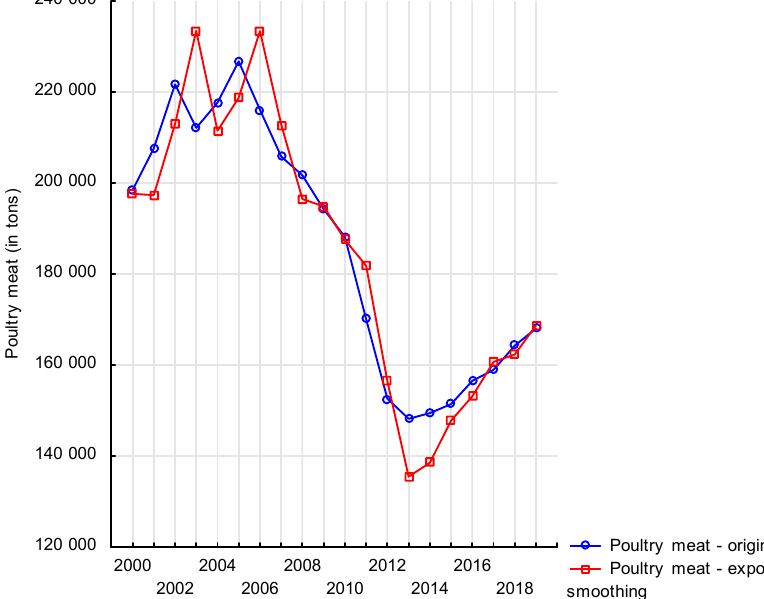
Figure 9. Poultry meat production in the Czech Republic (in tons) [27].